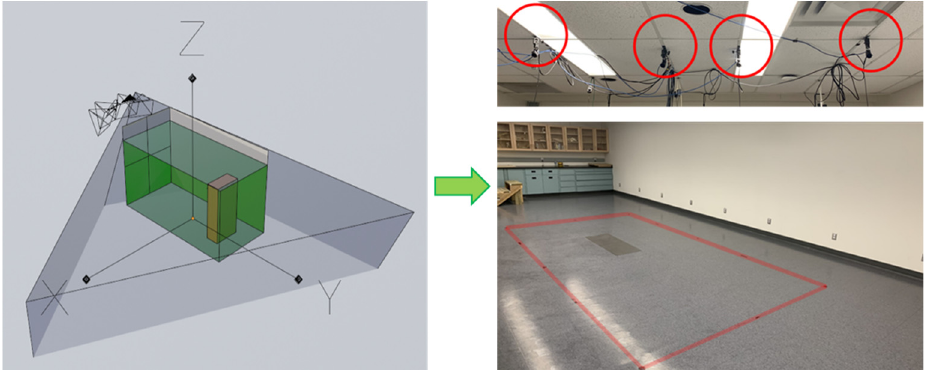
Figure 2. Smart Hallway simulated camera-arc layout and the implemented setup for validation. X, Y, and Z define the capture volume coordinate system.